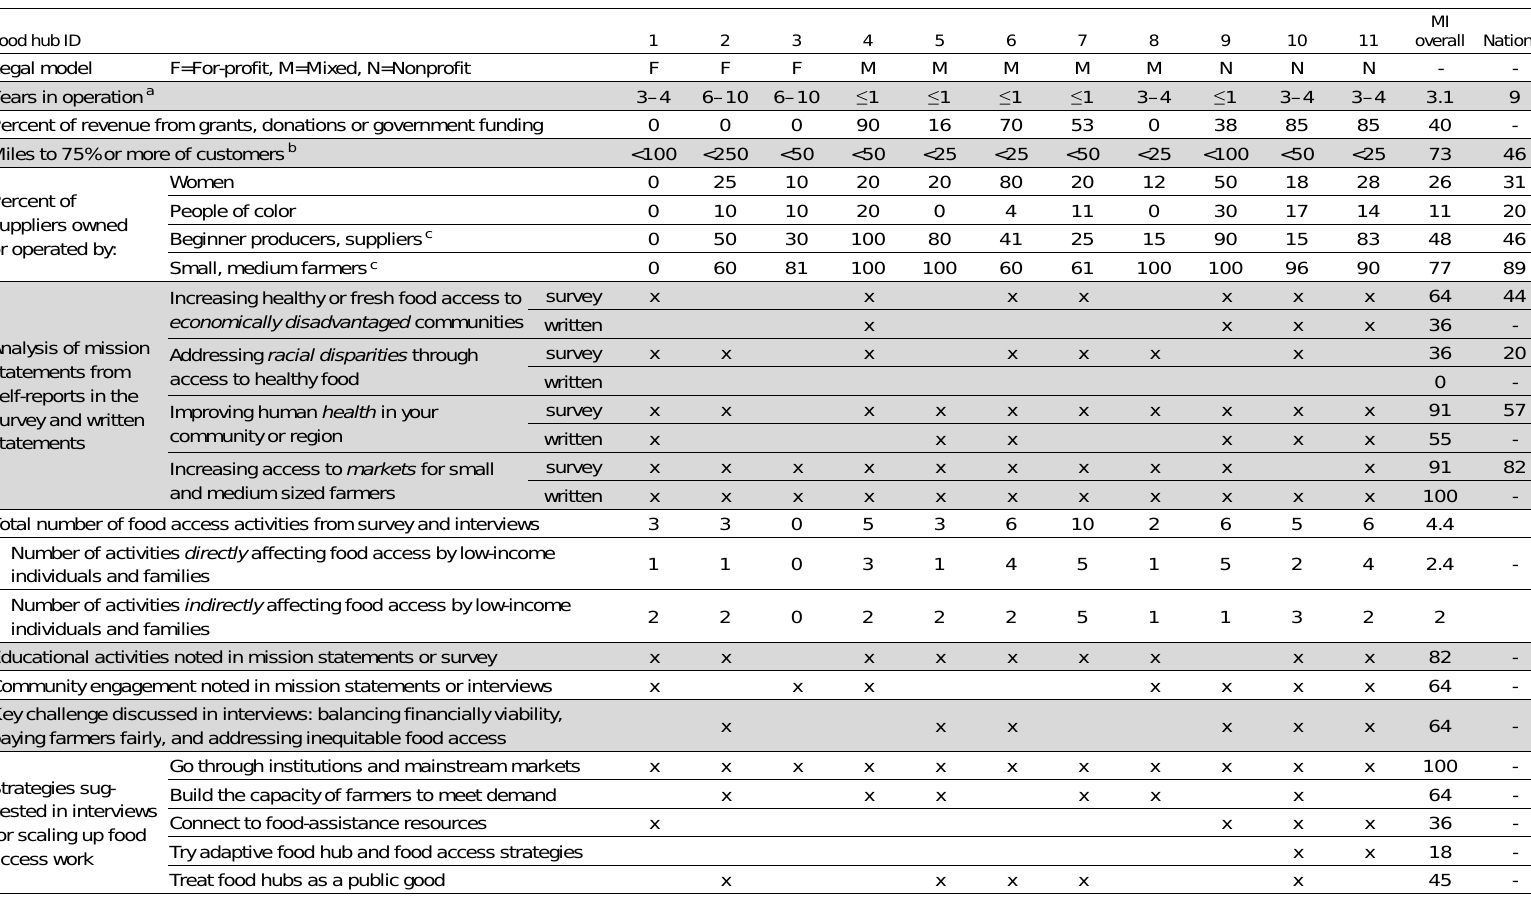
Table 1. Summary of Food Hub Characteristics, Missions, Food Access Activities, Challenges, and Scaling Up Strategies, by Food Hub, Overall and